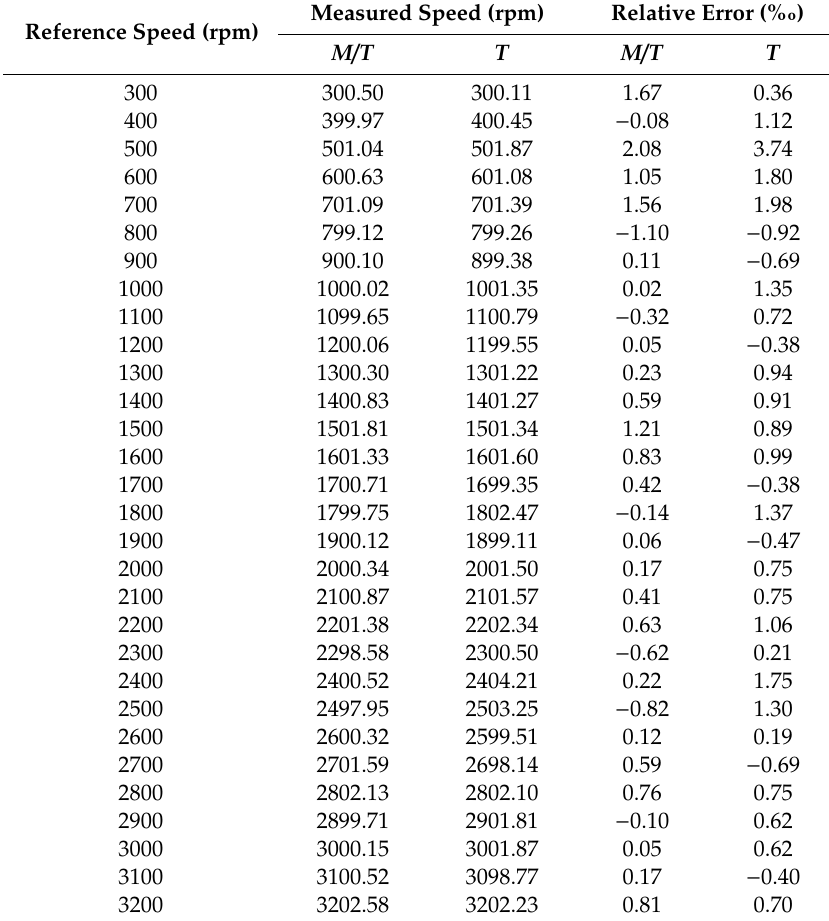
Figure 18. Measurement speed. Table 1. The relative errors of the measurement points.